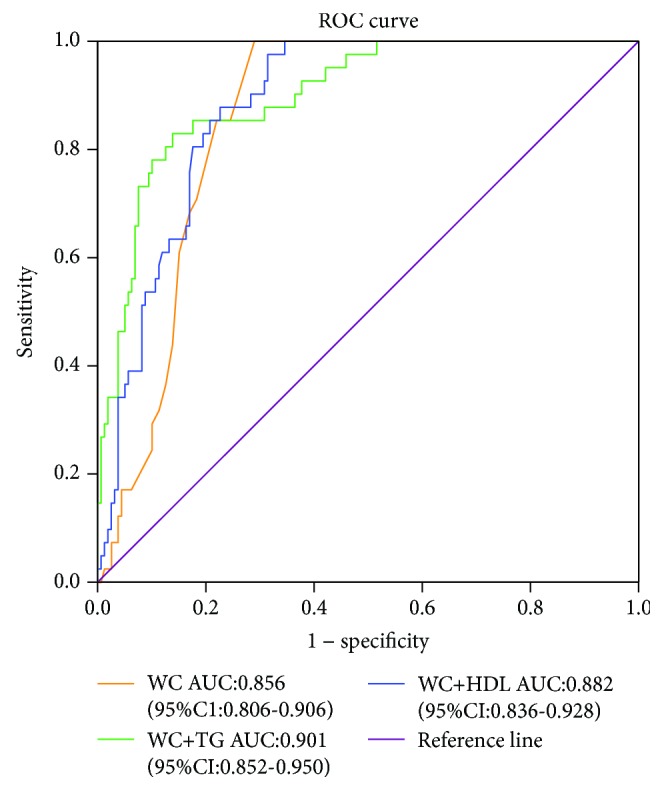
Receiver operating characteristic curve for assessing the screening ability of waist circumference (WC), WC coupled with triglycerides (TG), and WC coupled with high-density lipoprotein cholesterol (HDL-C) in PCOS patients (n = 200). AUC: the areas under the ROC curve. Reference line: chance line.